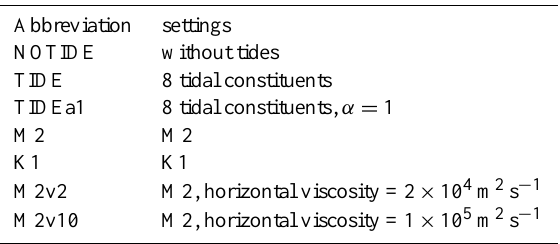
Table 2. Experimental cases simulated using our new scheme with